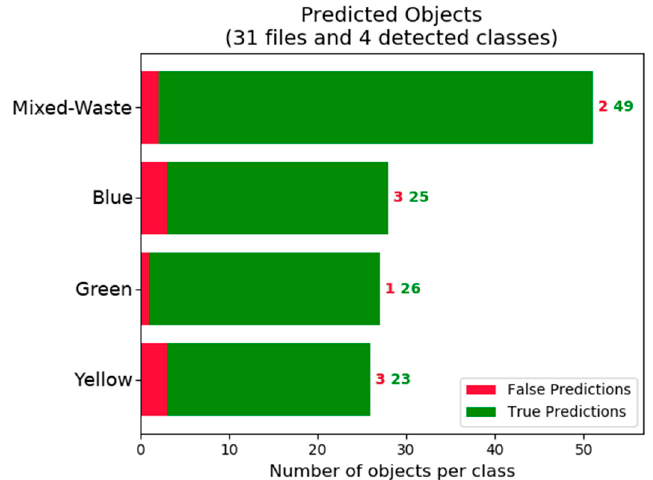
Figure 5. The number of false predictions and true predictions per object class after detection.